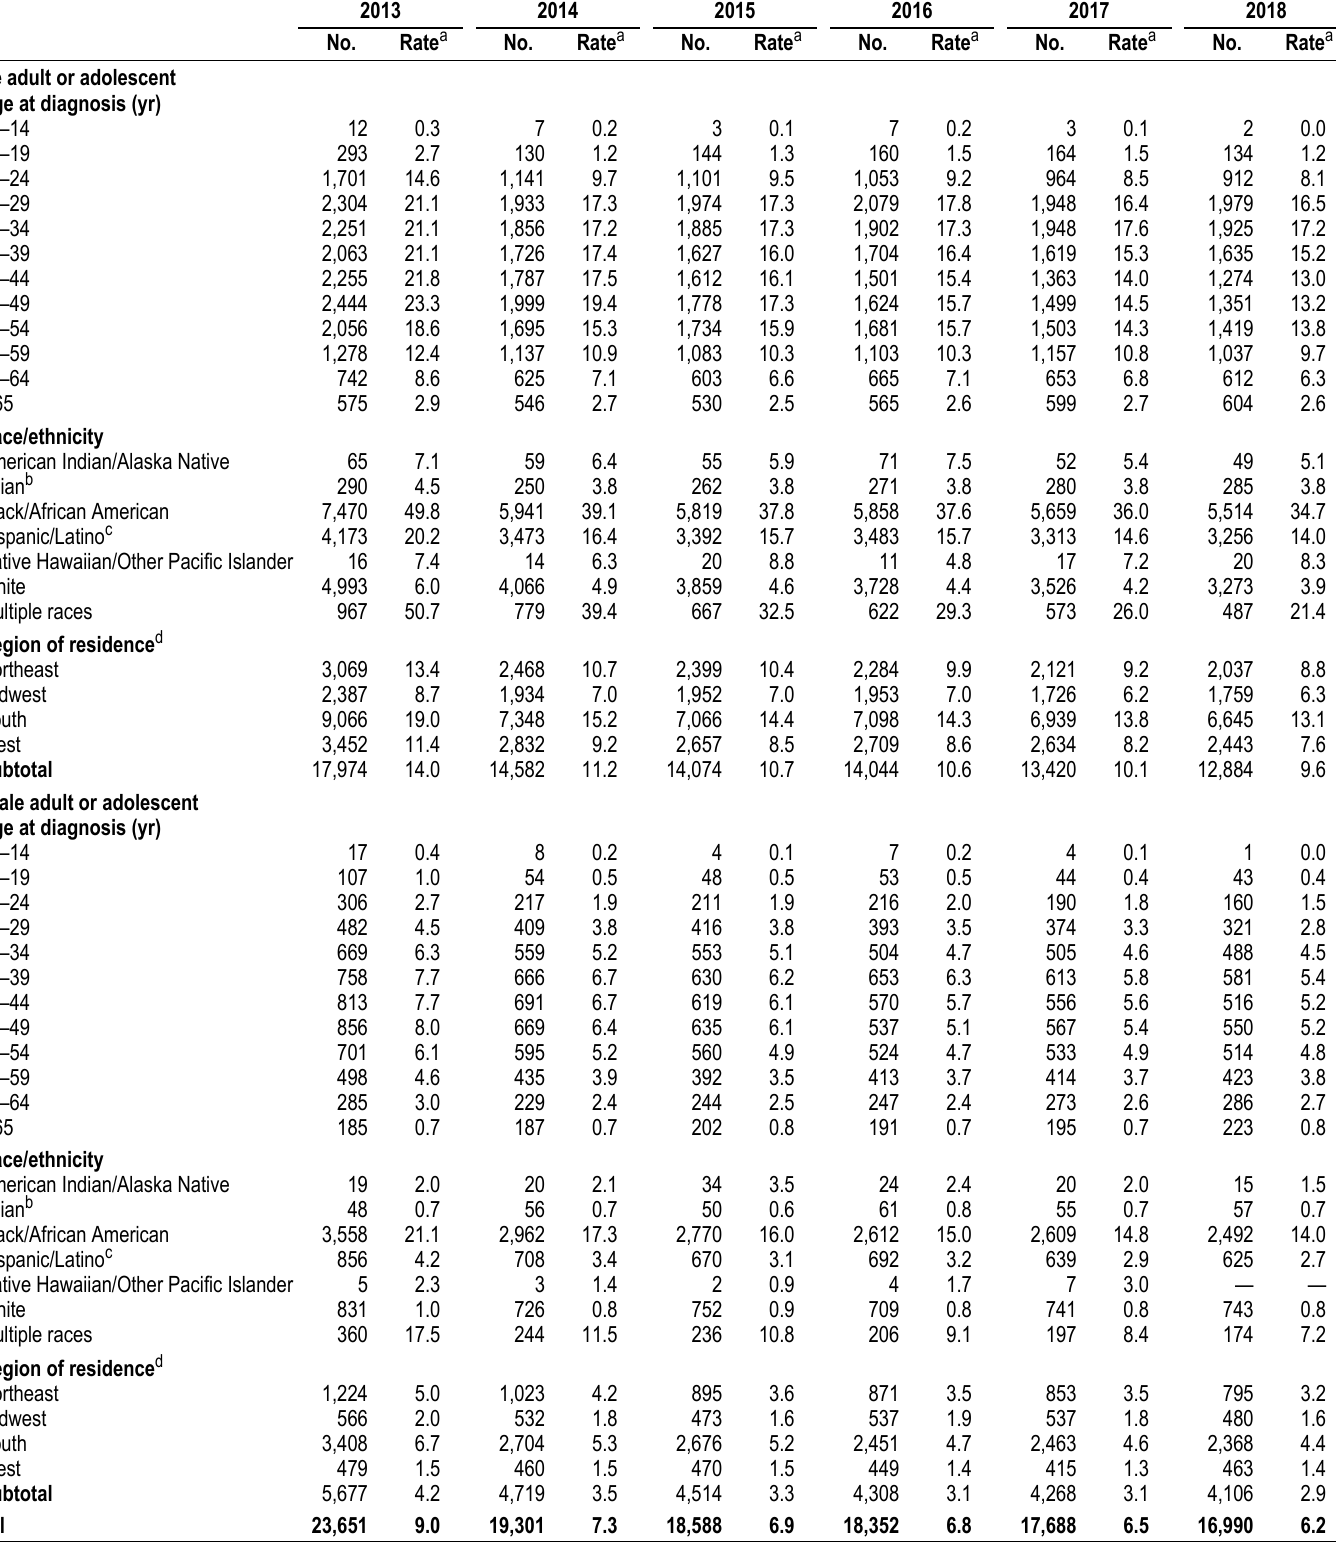
Table 6a. Stage 3 (AIDS) among adults and adolescents, by year of diagnosis, sex, and selected characteristics, 2013–2018—United